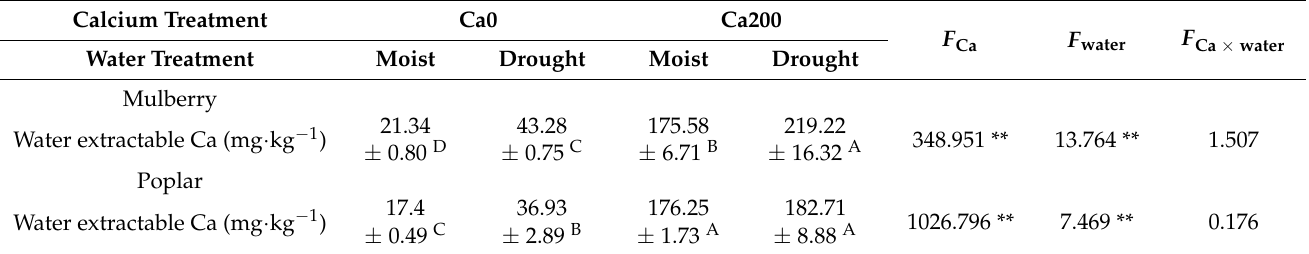
Table 1. Effects of water and Ca treatments on soil water extractable Ca of the two species. Different letters indicate significant differences ( p < 0.05) among treatments. Treatment values shown as mean ± SE (n = 6). Results of the two − way ANOVA addressing effects of Ca and water treatments are summarized at the bottom. ** indicate that the F value is significant at